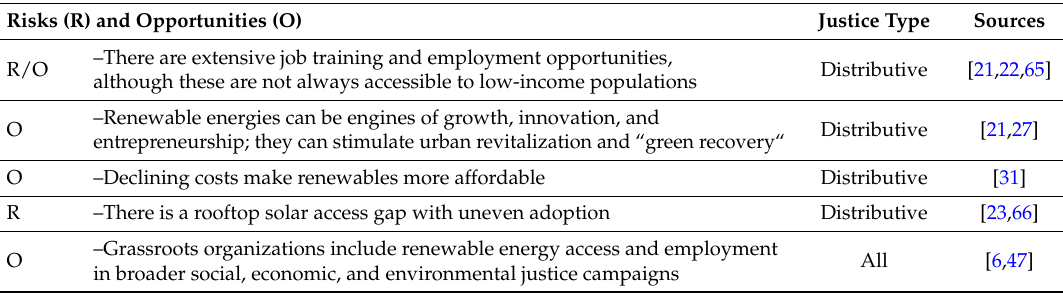
Table 5. Equity and justice potential from renewable